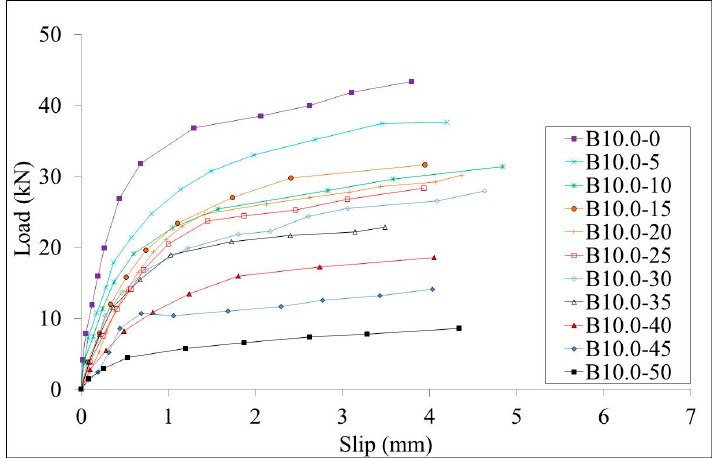
Figure 8. Load-slip curves of the B10.0 series specimens.